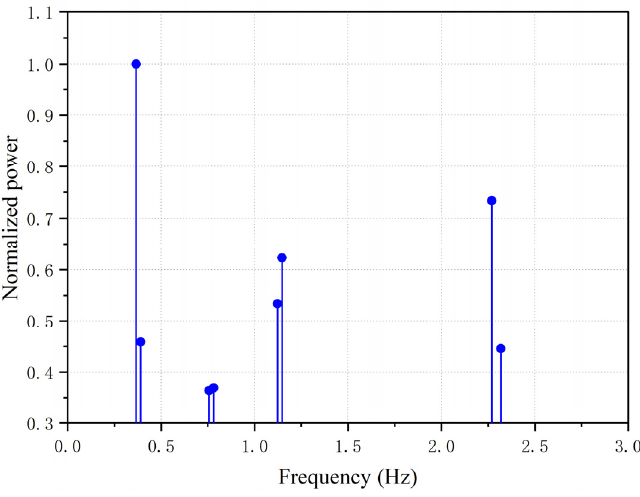
Figure 5. The results obtained by SFFT (SRN = 30). According to Figure 5, the eight frequency points obtained by using the SFFT algorithm were 0.3906, 0.4150, 0.7813, 0.8057, 1.1475, 1.1719, 2.2949, and 2.3438 Hz,